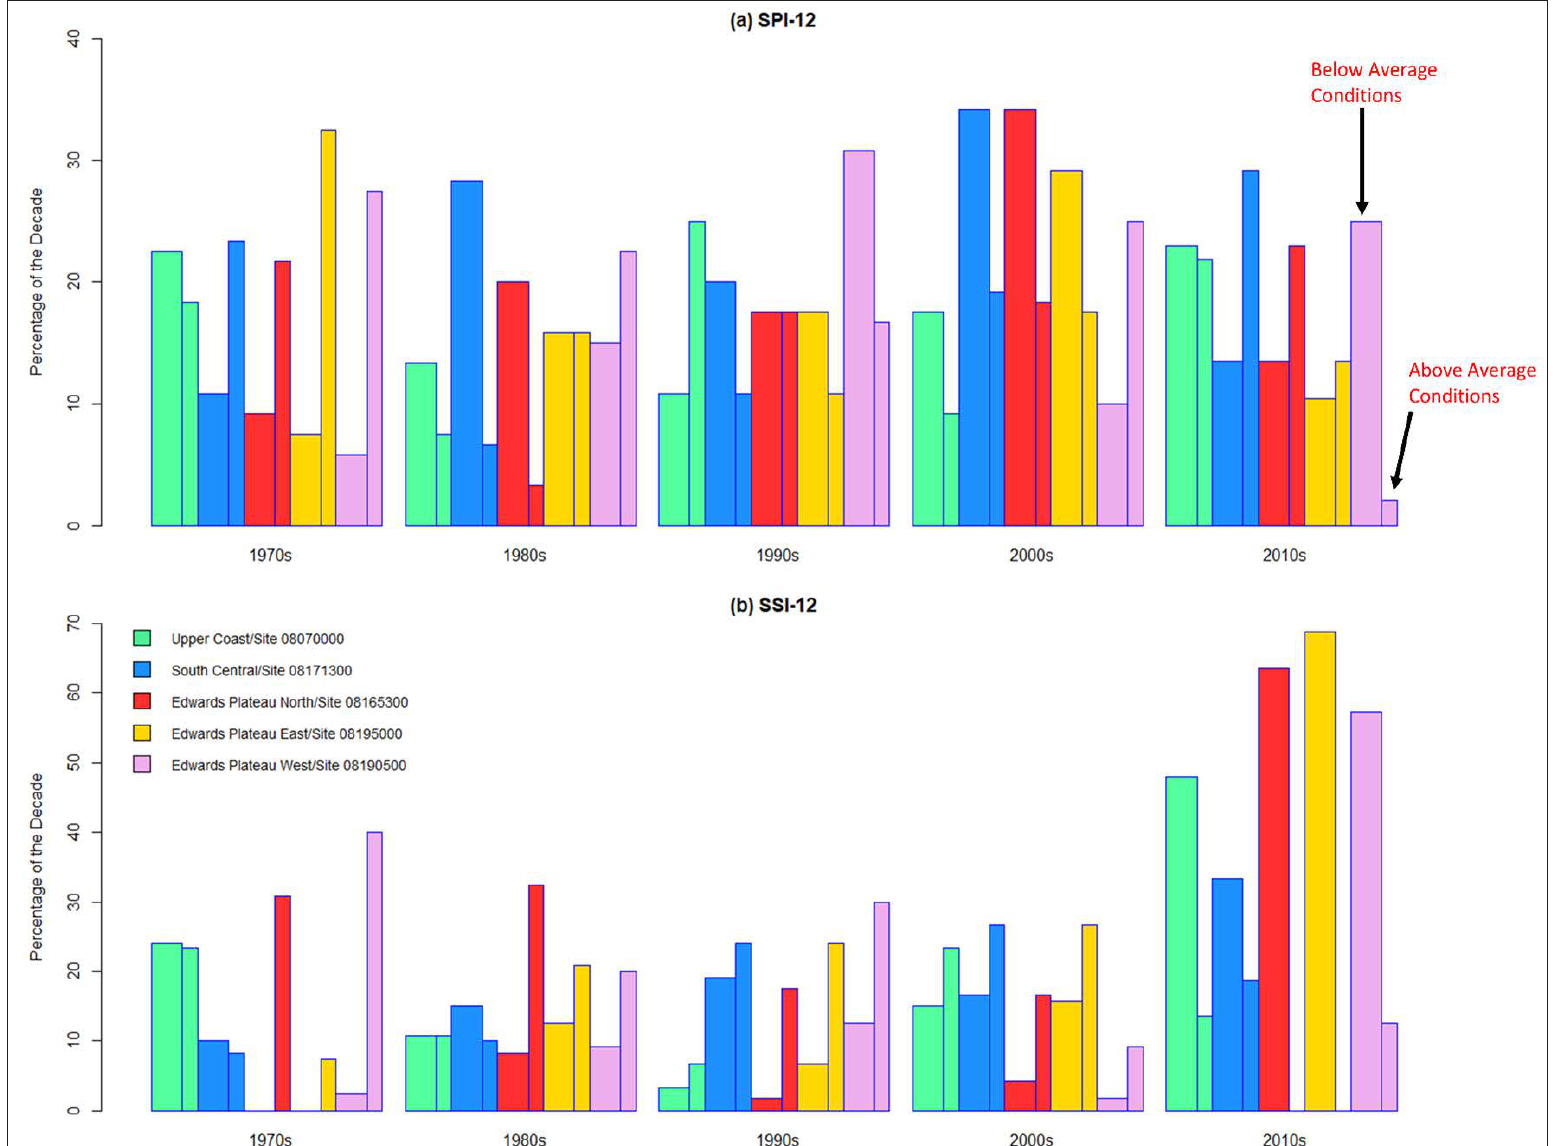
Figure 9. Total percent of the water year decade with below and above average (a) SPI-12, and (b) SSI-12 (the thicker bars show below-average conditions and the thinner bars show above-average